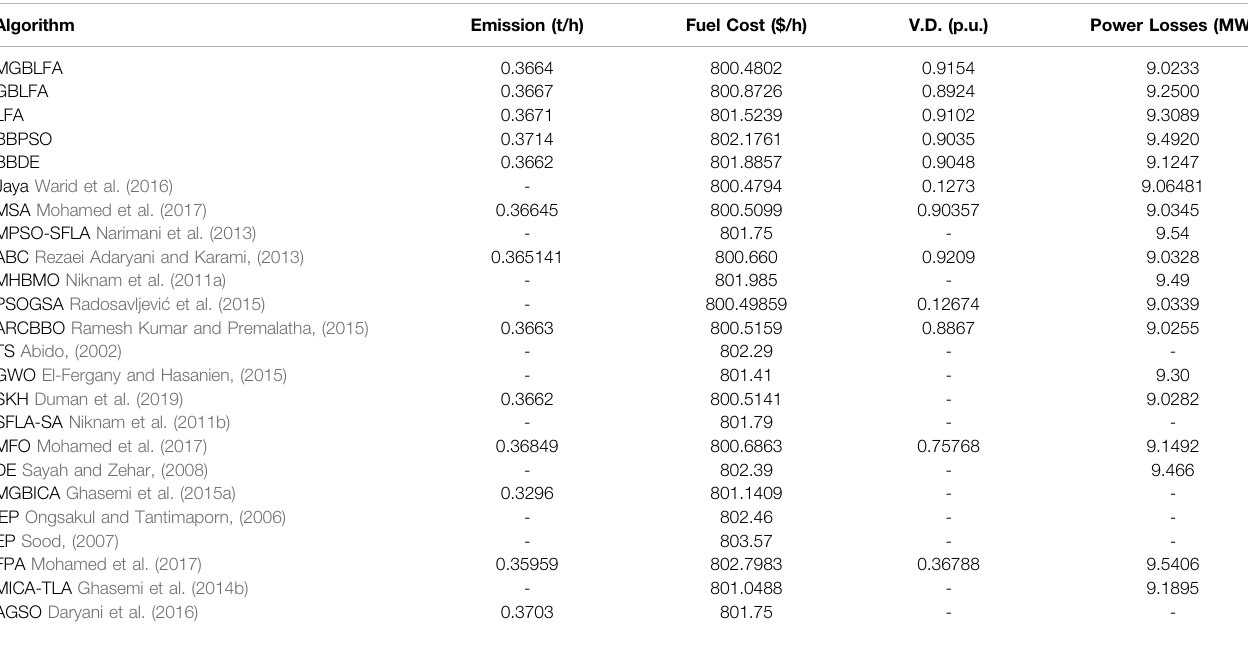
TABLE 2 | Comparison of optimal results by algorithms for Case